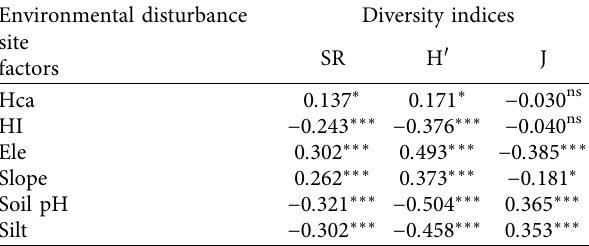
Table 9: Pearson correlation coefcients between diversity indices and environmental and disturbance factors in MFBR.